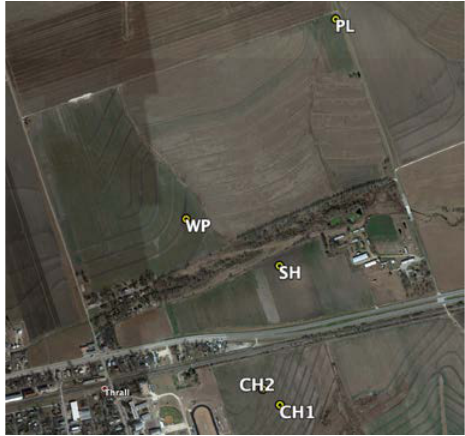
Figure 1. The study was conducted on Stiles farm located in Williamson County, central Texas. The five areas of field experiments are marked on the map.